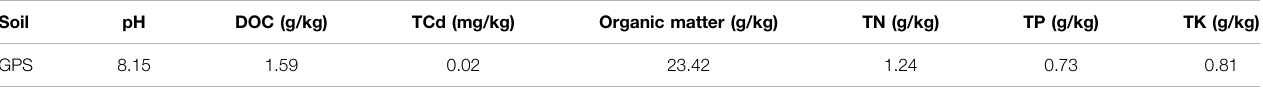
TABLE 2 | Basic physicochemical properties of soil sample.